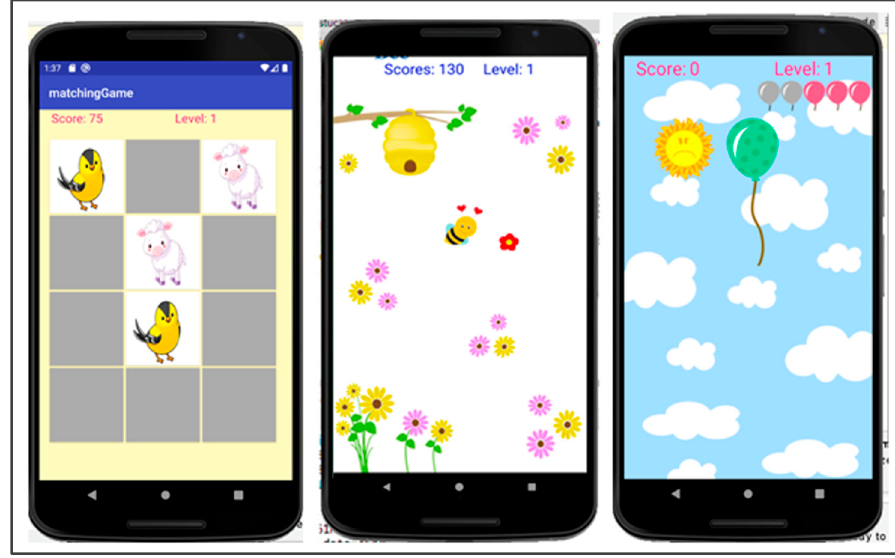
Figure 4. Games examples that were used in the teaching mobile app development course.